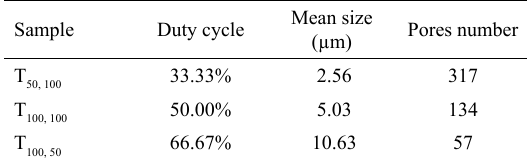
Table 1. Size and number of pore in area of 2500 µm 2 of the sample surface plasma treated.